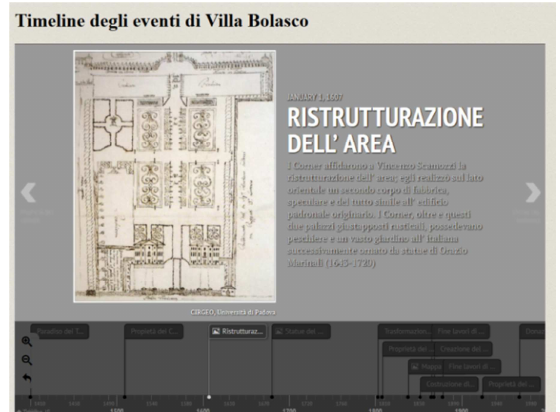
Figure 13. The timeline bar displaying as et of events related to Villa Revedin Bolasco.